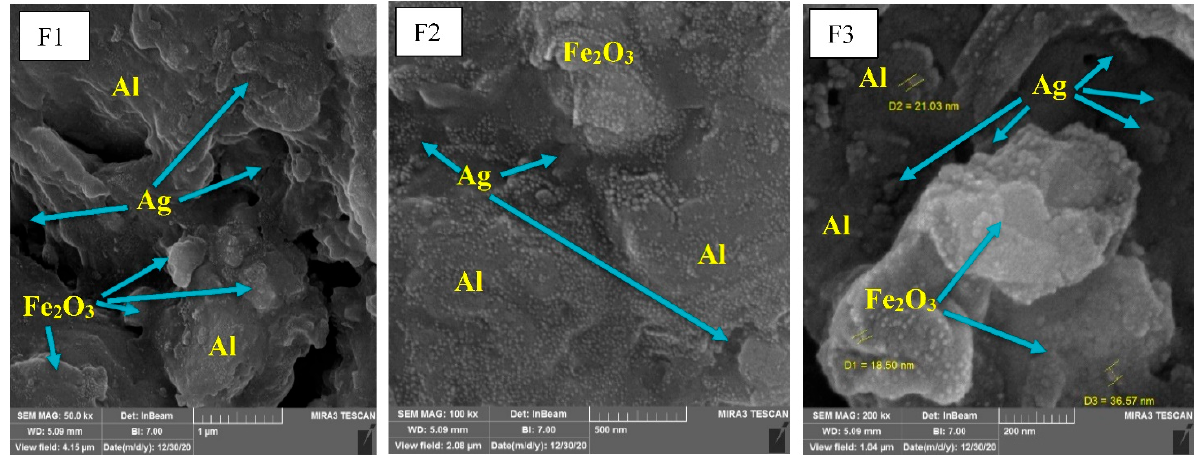
Figure 1. FESEM images of the samples with different percentages of Fe 2 O 3 and 1% Ag: ( A1 – A3 ) pure Al; ( B1 – B3 ) Al/3 wt.% Fe 2 O 3 +1 wt.% Ag; ( C1 – C3 ) Al/6 wt.% Fe 2 O 3 + 1 wt.% Ag; ( D1 – D3 ) Al/9 wt.% Fe 2 O 3 + 1 wt.% Ag; ( E1 – E3 ) Al/12 wt.% Fe 2 O 3 + 1 wt.% Ag; and ( F1 – F3 ) Al/15 wt.% Fe 2 O 3 + 1 wt.% Ag.